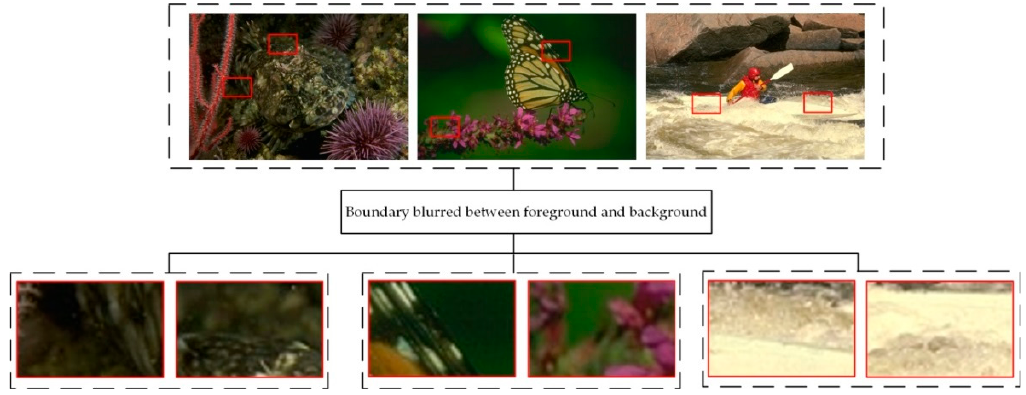
Figure 6. Schematic diagram of blurred boundaries between foreground and background. It is deserved to be mentioned that the outline and edge information of foreground and background is the important information for superpixel segmentation, and also the significant basis of accurate segmentation of the superpixel. The active contour model transforms the segmentation problem into solving the minimum energy functional problem.